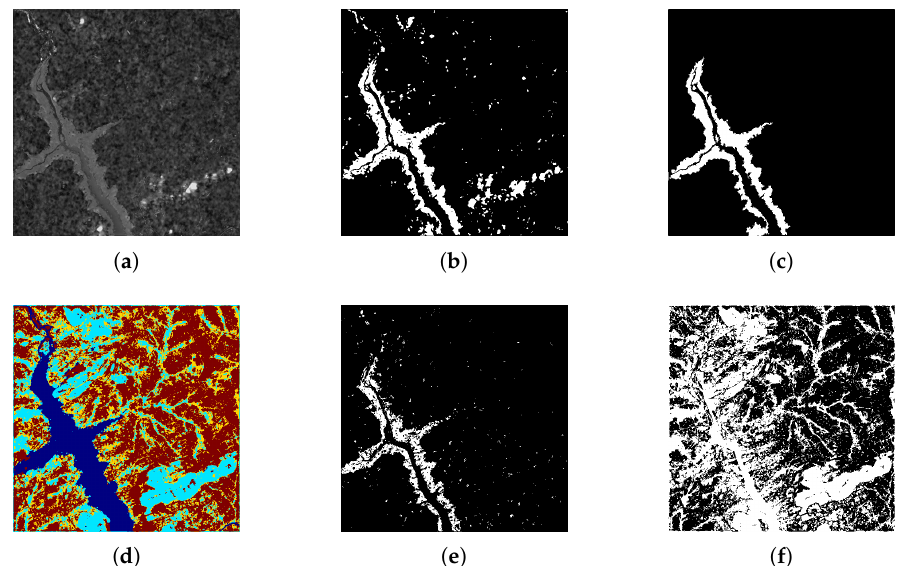
Figure 9. Anomaly detection in SITS—flooding use-case scenario. From left to right: ( a ) matrix of d max values, ( b ) anomaly identification using the proposed approach, ( c ) ground truth, ( d ) DTW-based clustering of heterogeneous SITS using the approach proposed in Ref. [5], ( e ) retrieval of similar evolution patterns in heterogeneous SITS using DTW-EM method described in Ref. [36], and ( f ) change map obtained using ACE-Net presented in Ref. [10].